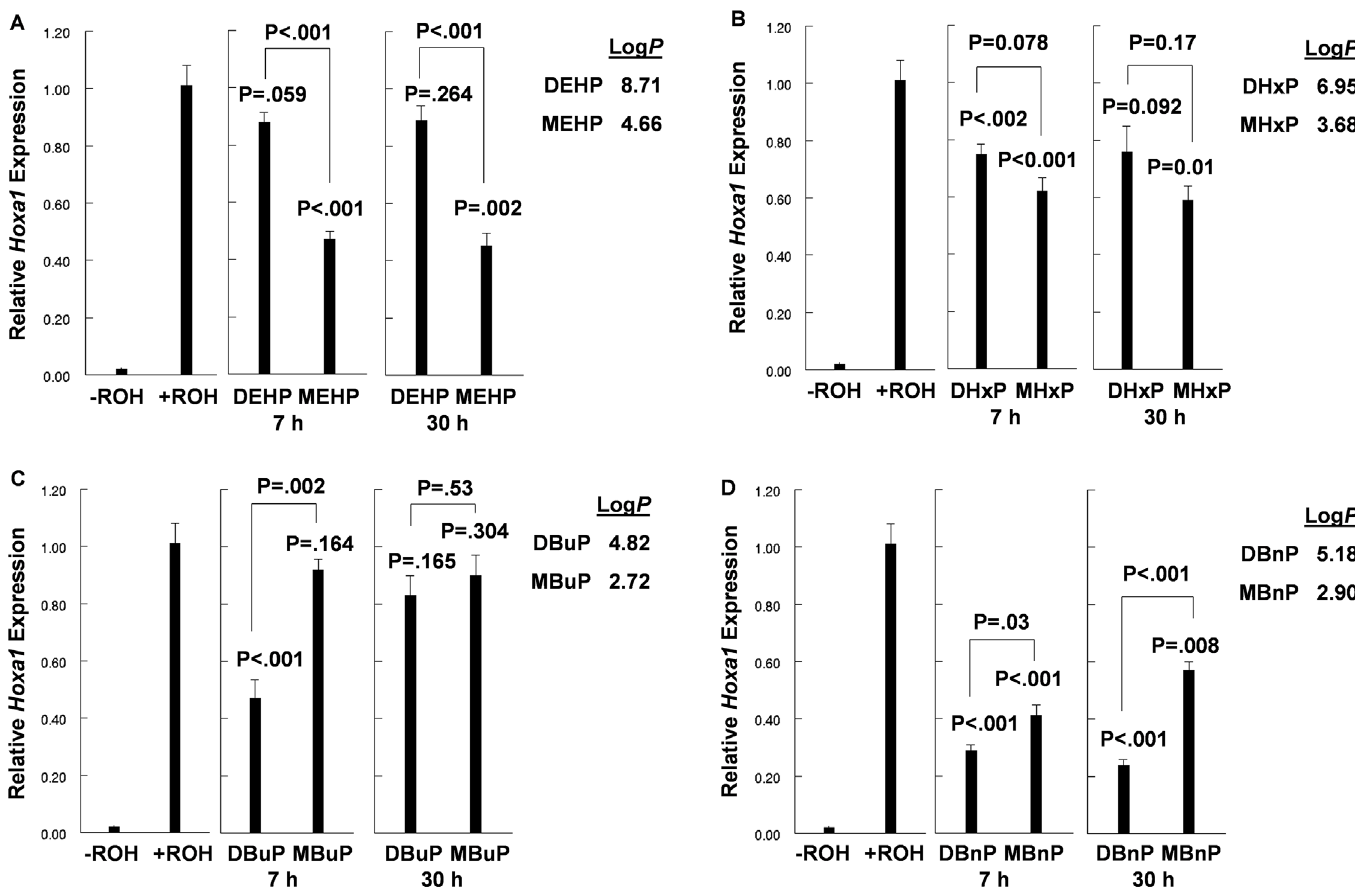
Fig 4. Comparison of the effects of phthalate diesters and cognate monoesters on the induction of Hoxa1 expression by ROH. P values for phthalate effects on Hoxa1 expression compared to +ROH controls are indicated at the top of each bar. n = 4.